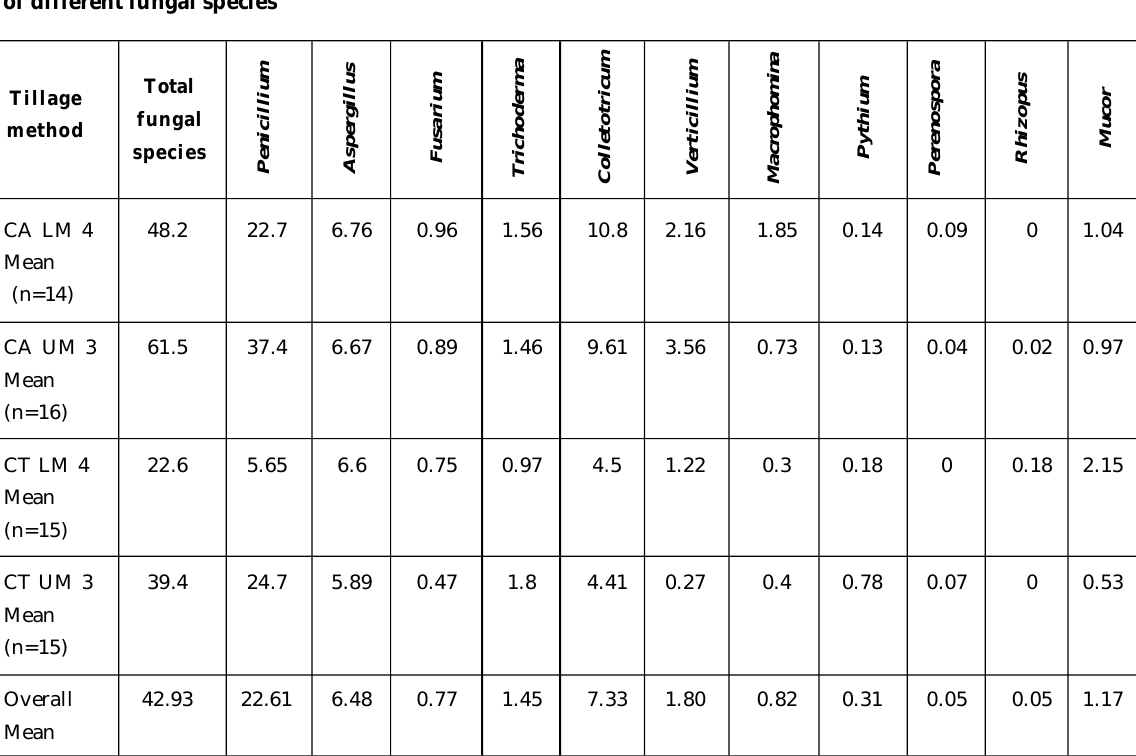
Table 2: Effect of tillage method on mean soil population (CFUs x 10 4 per gram) of different fungal